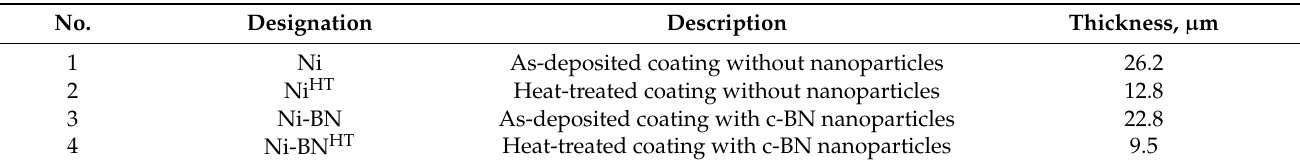
Table 1. Designation and thickness of the tested